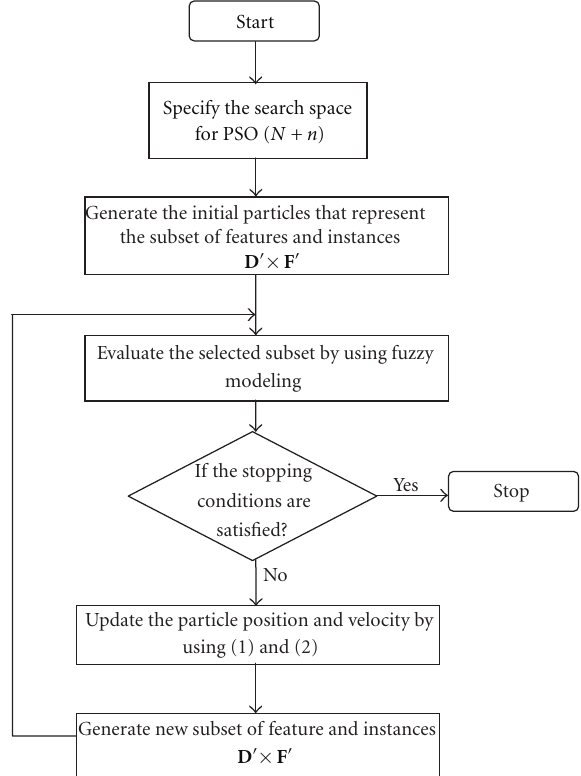
Figure 2: The scheme of the proposed data and reduction for fuzzy